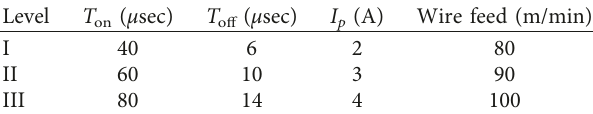
Table 1: Levels of DOE.